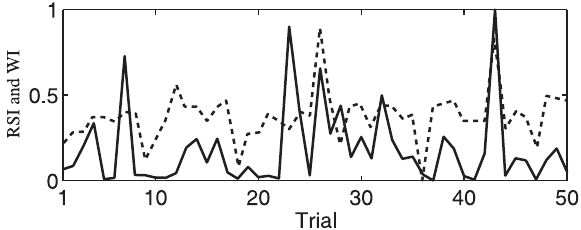
Figure 9. The reaction speed index ( RSI ) and wave index ( WI ) over trials for a typical subject; solid line for RSI and dashed line for WI . The wave index was calculated for the F-to-O alpha waves.